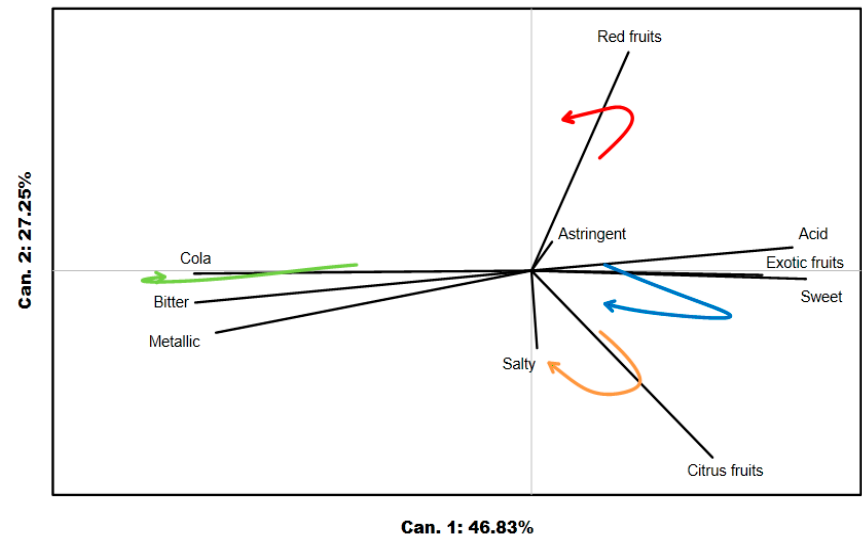
Figure 5. The sensory trajectories of the four products are represented on a PCA (Principal Component Analysis) biplot for TCATA (Temporal Check-All-That-Apply) at 10 equally spaced time points during oral processing. The sensory trajectories of the four products are each indicated by a different color: blue, ODT_exotic; green, ODT_cola; red, ODT_red; and orange, ODT_citrus.